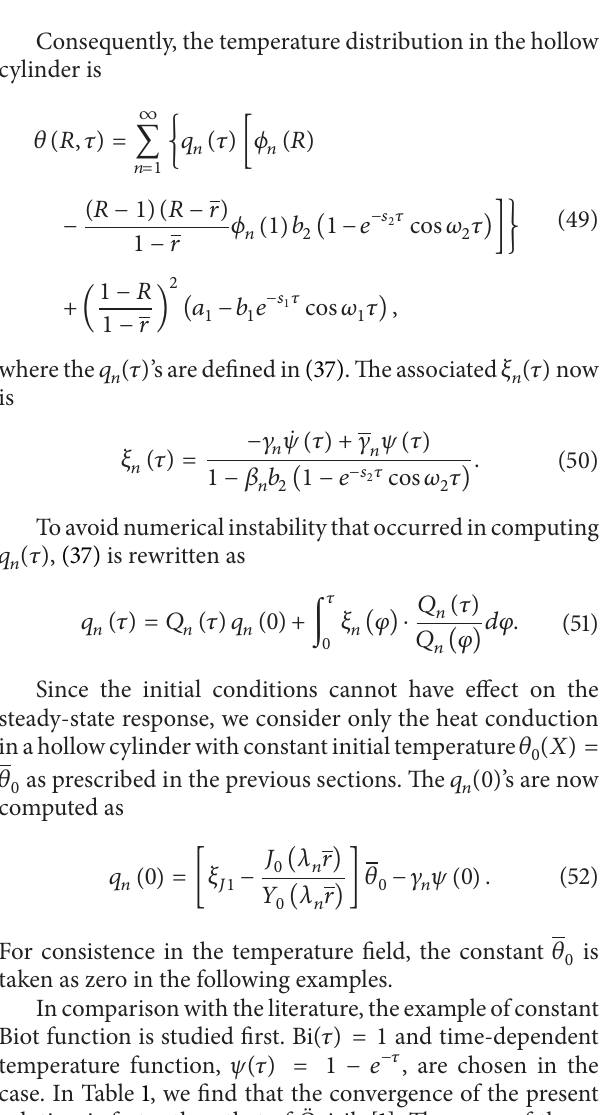
Table 2: Temperatures of the hollow cylinder at outer surface